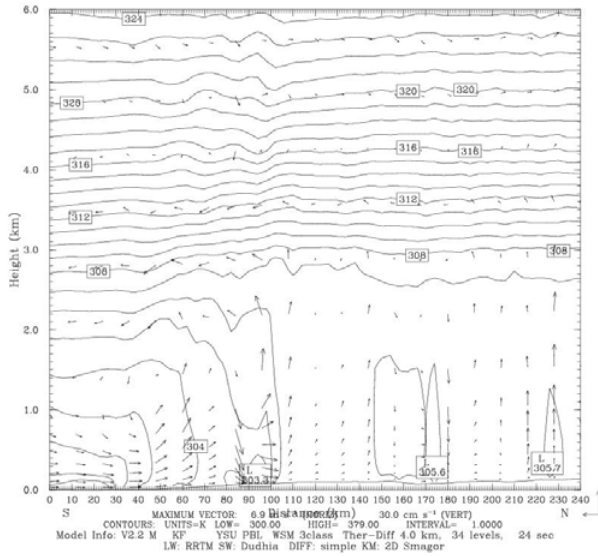
Figure 3. WRF simulated vertical cross-section of potential temperature and circulation vectors at 15 LT, 1 June